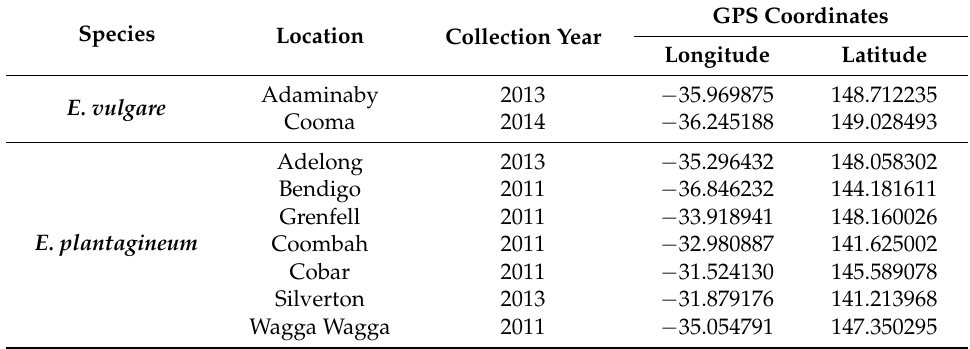
Table 2. Location and harvest date for root samples used in creation of the libraries and sources of seed used in the controlled conditions